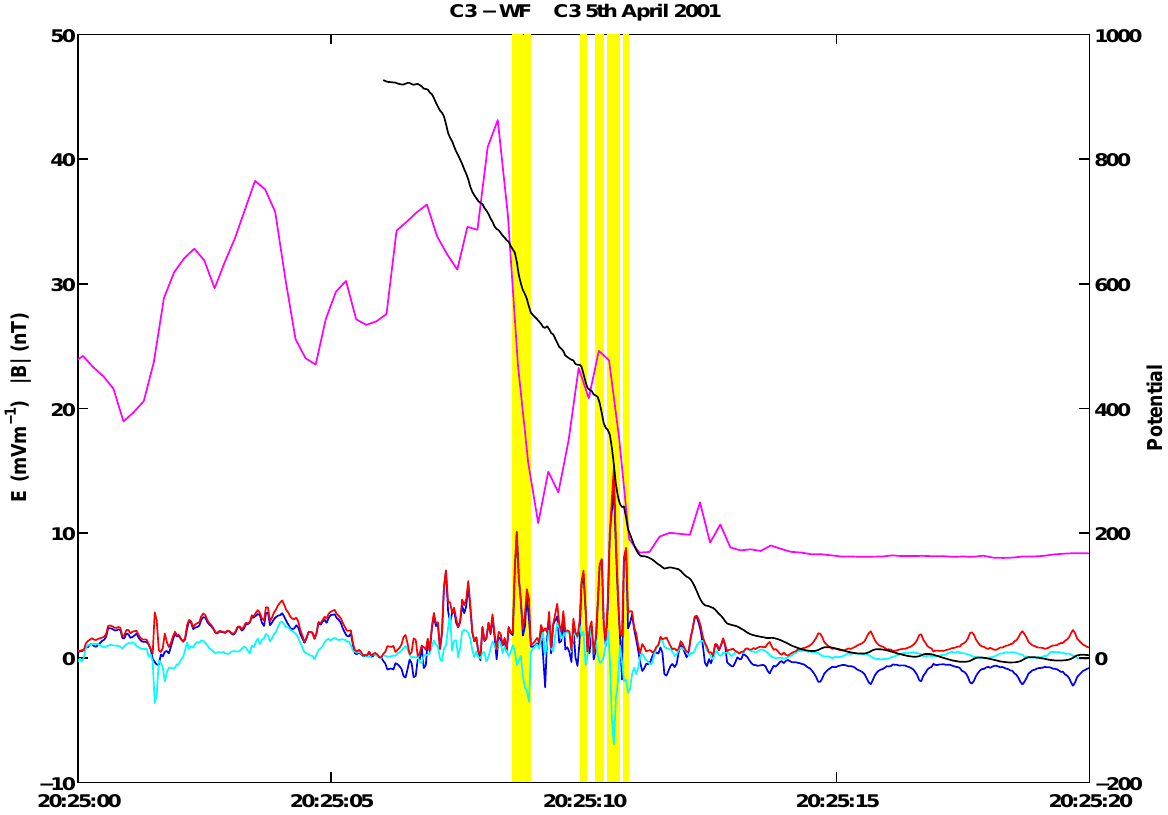
Fig. 7. The magnitude (red), and E x (blue) and E y (cyan) components of the spin plane electric field measured by Cluster 3 on 5 April 2001 around 20:25 UT. The yellow regions highlight the periods when large amplitude short duration spikes in the electric field are observed. The black line (Y scale of RHS) represents the change in potential within the